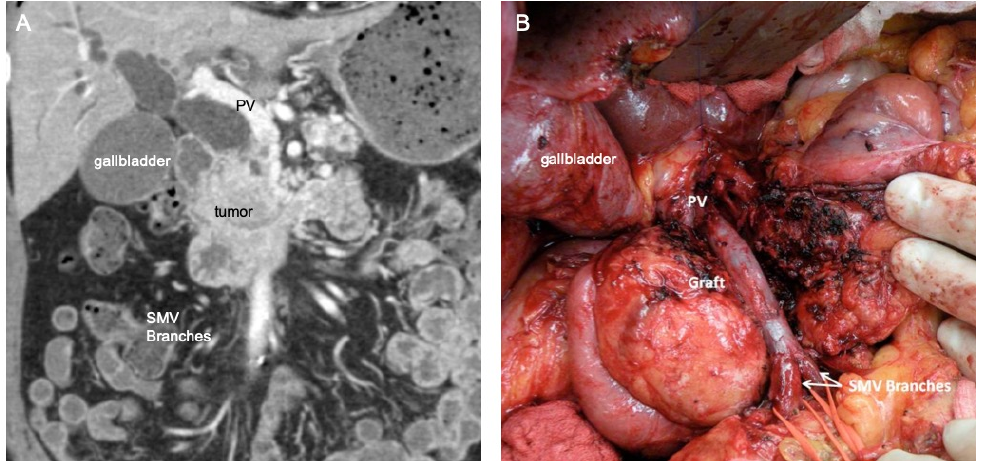
Figure 1. Coronal computed tomography (CT) image of ( A ) a pNET that involves a segment of the superior mesenteric vein down to the level of the jejunal and ileal vein branches, and ( B ) intraoperative photograph of the completed vein reconstruction where the portal vein was mobilized, the inferior mesenteric vein was taken, and distal SMV branches were connected together to facilitate an interposition graft with the internal jugular vein. PV, portal vein; SMV, superior mesenteric vein.